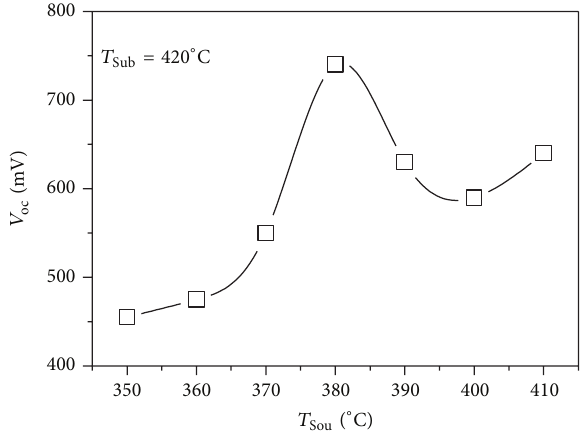
Figure 6: Thermal annealing in CdCl 2 vapor of the CdTe/ CdS/CIO/glass part of the cell. 𝑇 was varied in the interval 350–410 ∘ C. PP constant. Lines joining the experimental points were outlined only as a visual guide to the